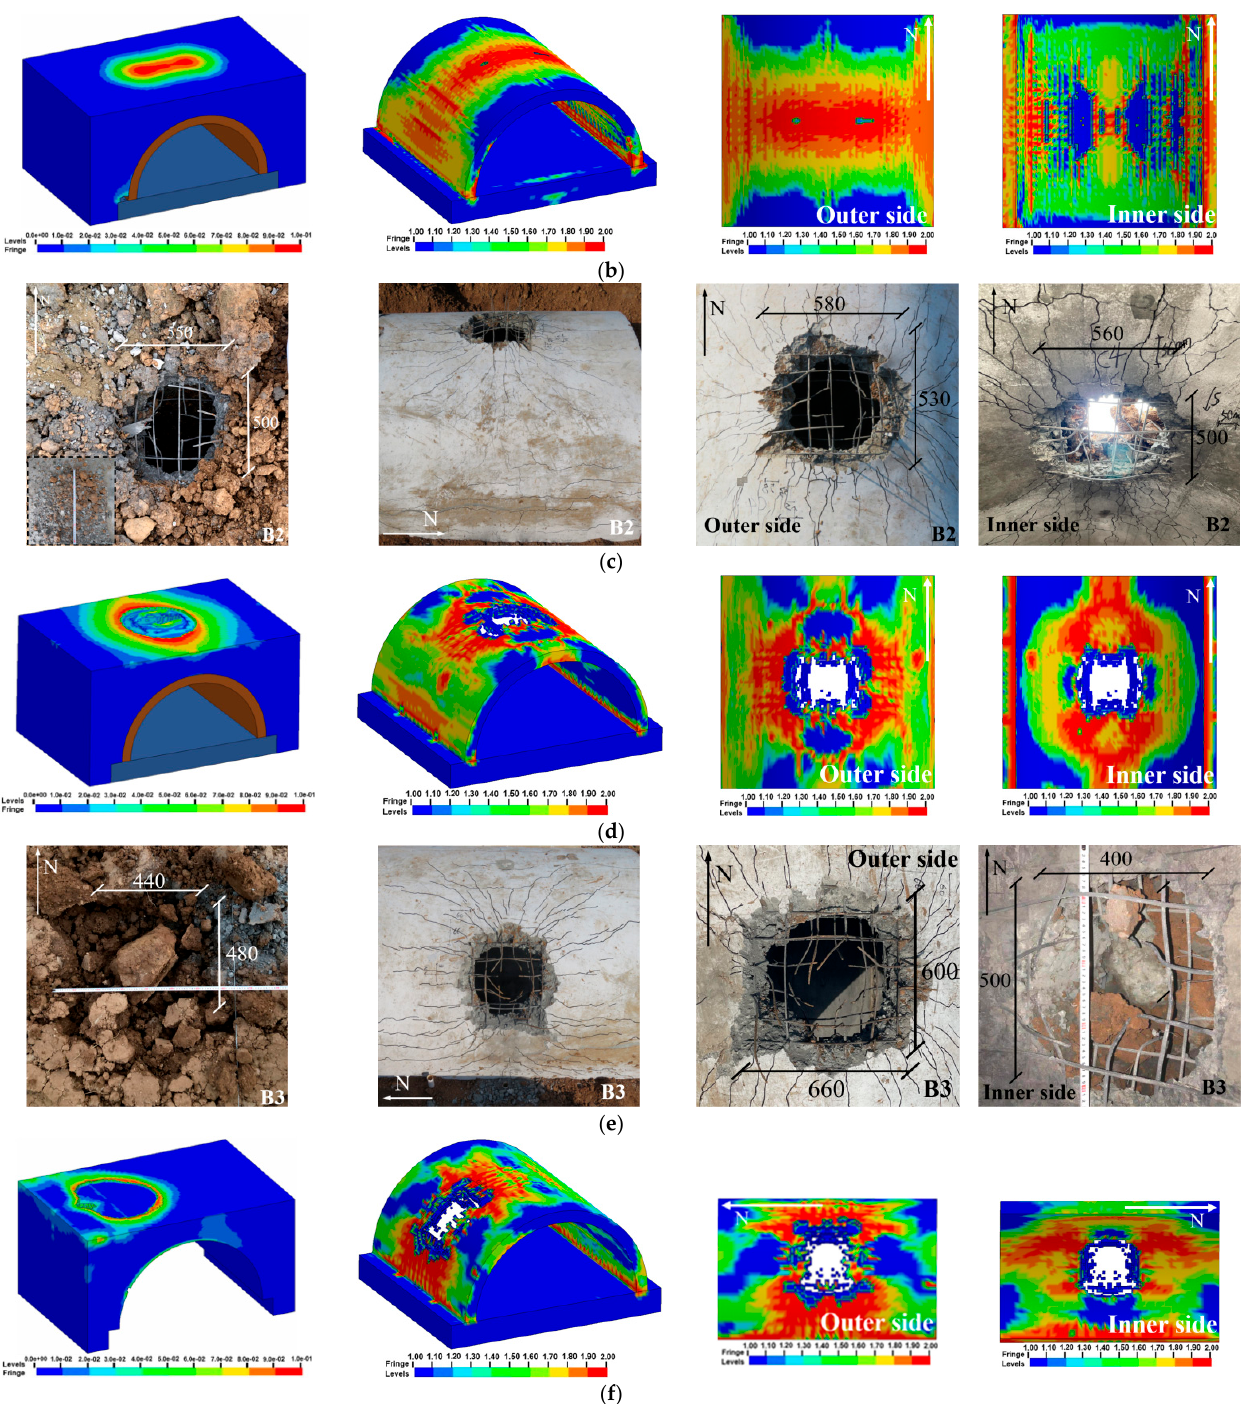
Figure 9. Experimental and simulated damage pattern of the specimens under explosion load (unit: mm) : ( a ) Case B1-test; ( b ) Case B1-simulatoin; ( c ) Case B2-test; ( d ) Case B2-simulatoin; ( e ) Case B3-test; ( f ) Case B3-simulatoin.